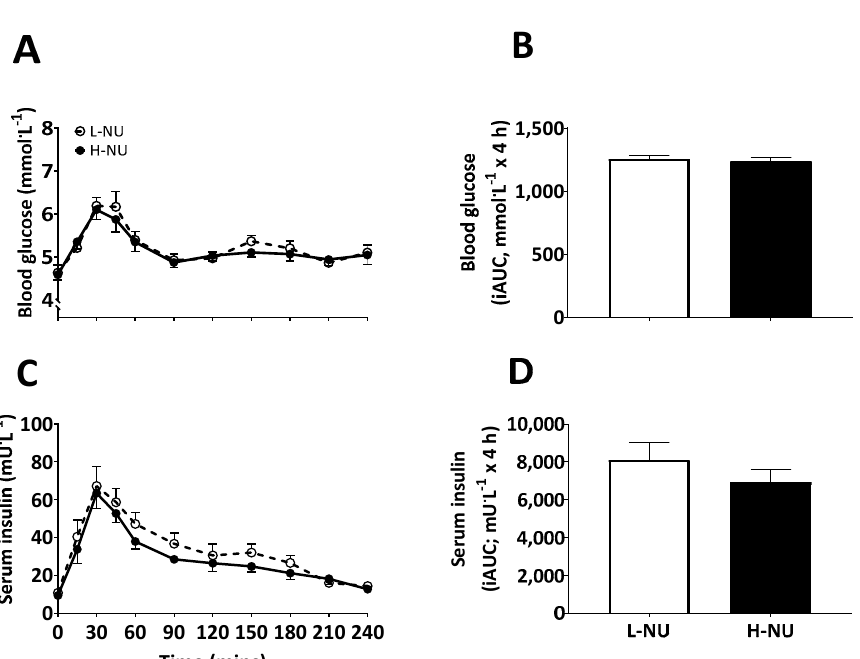
Figure 2. Temporal response and incremental area under the curve of blood glucose ( A and B ) and serum insulin ( C and D ) concentrations during the 4 h post-prandial period following the consumption of a nucleotide-depleted (L-NU) or nucleotide-rich (H-NU) mycoprotein-based mixed meal in healthy young adults ( n = 10). Data were analysed using two-way ANOVAs. Incremental area under the curve (iAUC) data were analysed using paired t-tests. Values are means with SEM represented by vertical bars. Main effects of time, condition, time x condition interaction and paired t-tests (all P > 0.05).